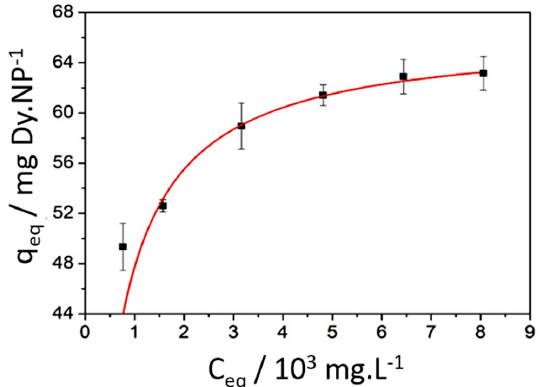
Figure 11. Adsorption isotherm of NP@DTPA in Dy 3+ solutions at 298 K, pH 6, from the data collected after 500 min, under stirring, for ensuring complete equilibration (adapted with permission from [35]). Its linearized form is shown in Figure